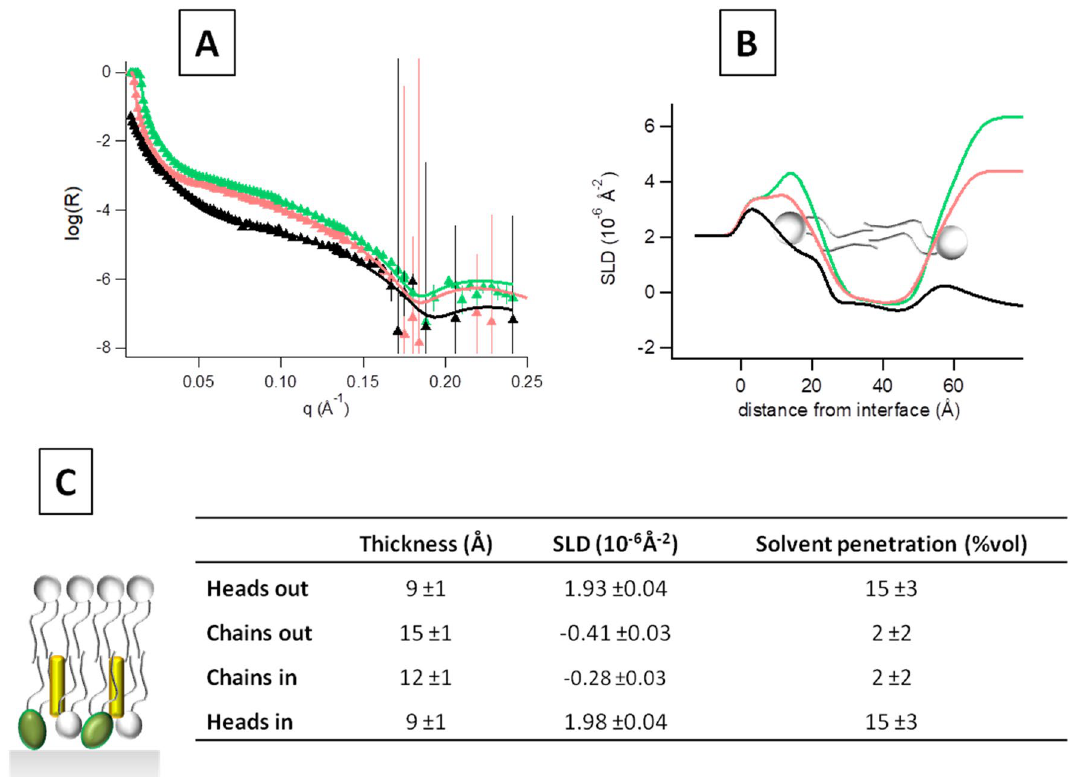
Figure 5. ( A ) Reflectivity curves of the supported PLPC/sitosterol/GluCer (60/20/20) membrane investigated in D 2 O (green), H 2 O (black) and 4 MW (pink) at room temperature. Symbols are the experimental point, lines the best fits, from which the SLD profiles showed in panel ( B ) are obtained with the software MOTOFIT 42,43 . ( C ) Common structural parameters used to contemporary fit the curves relative to the PLPC/sitosterol/GluCer membrane in the three contrast solvents. Errors on the single values have been determined from the fit quality though the χ 2